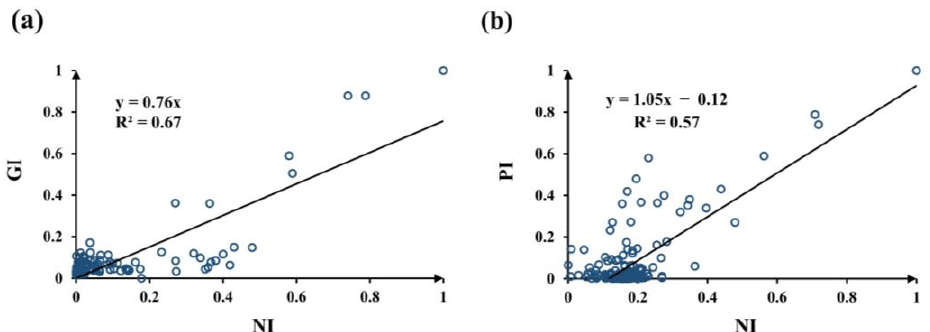
Figure 11. ( a ) Scatter plot of the GI and NI, where the black line indicates the best fitting line; and ( b ) scatter plot of the normalized slopes of the PI and NI, where the black line indicates the best fitting line.